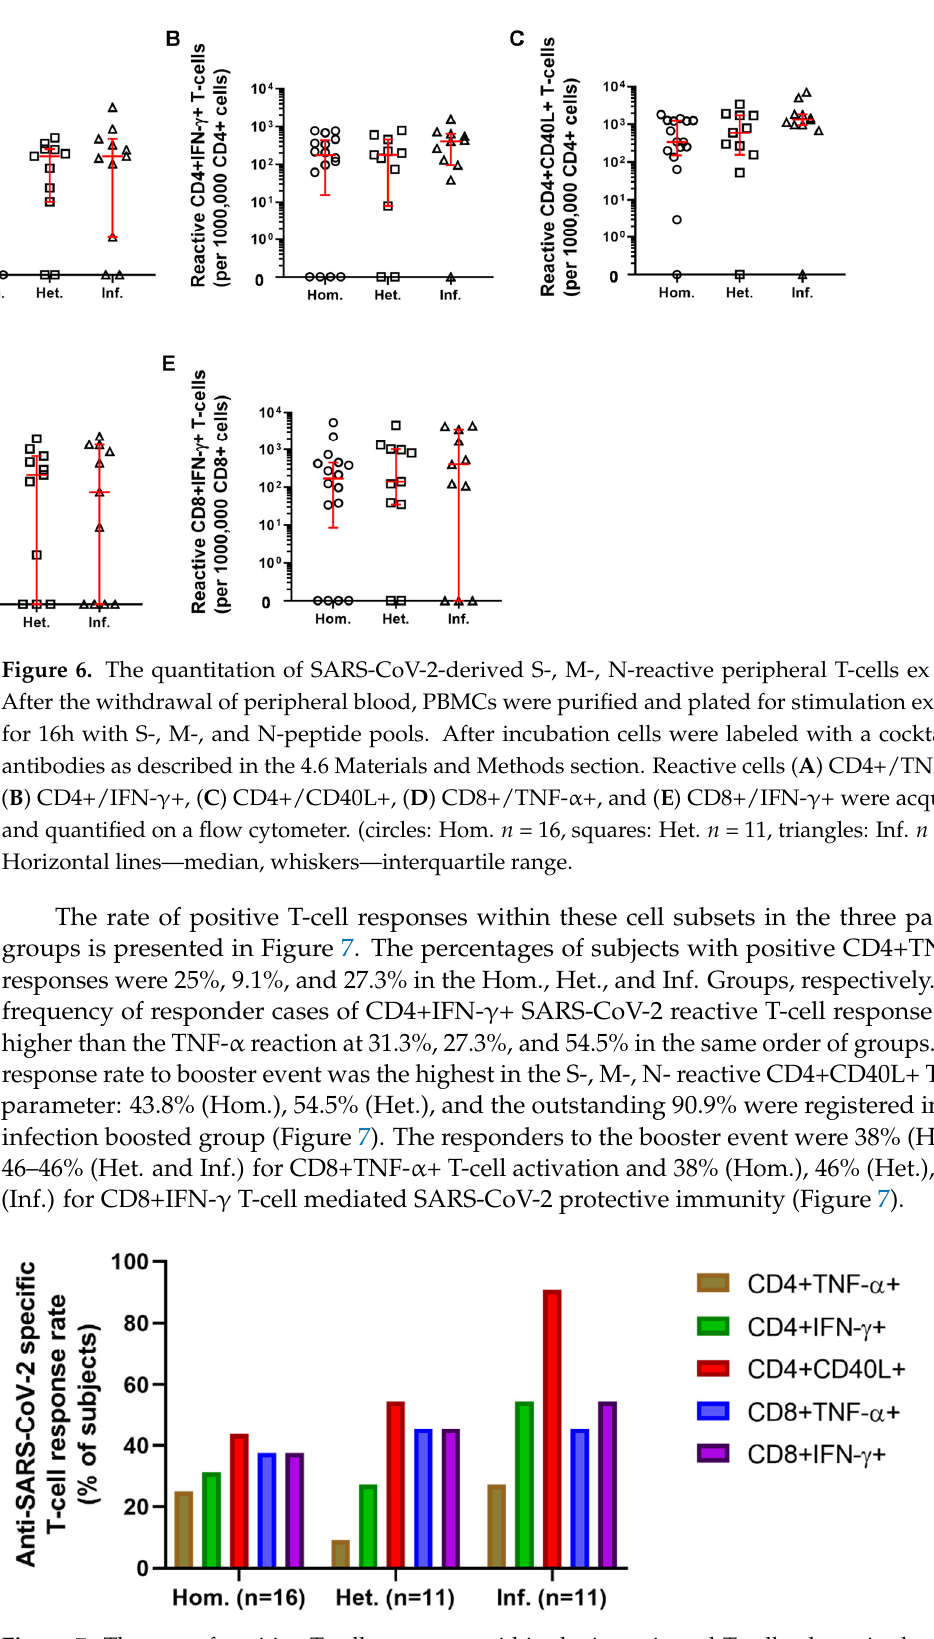
Figure 7. The rate of positive T cell responses within the investigated T cell subsets in the three patient groups.